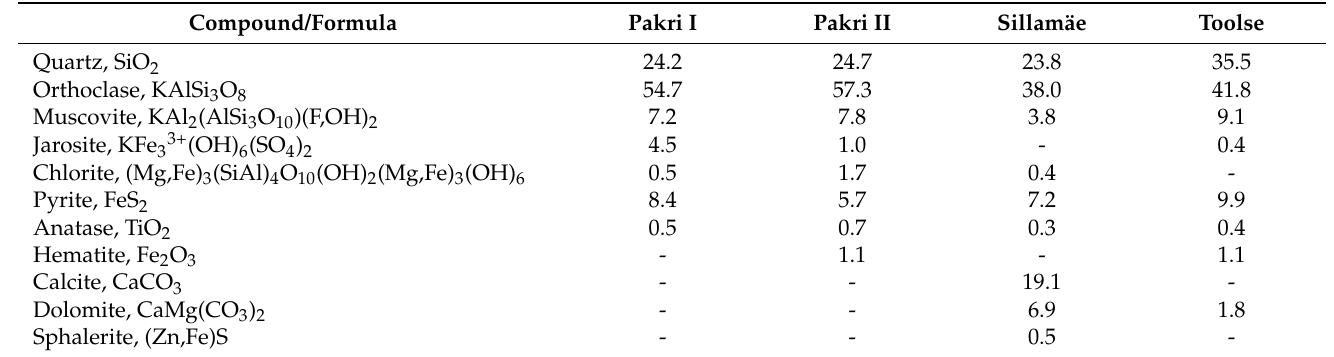
Figure 1. Distribution of the black shales of the Türisalu Formation. Yellow circles mark approximate locations of sampling sites. Türisalu is a village in Harku Parish, Sillamäe is a town in Ida-Viru County in the northern part of Estonia. Table 1. Mineralogical composition (wt%) of GA samples.